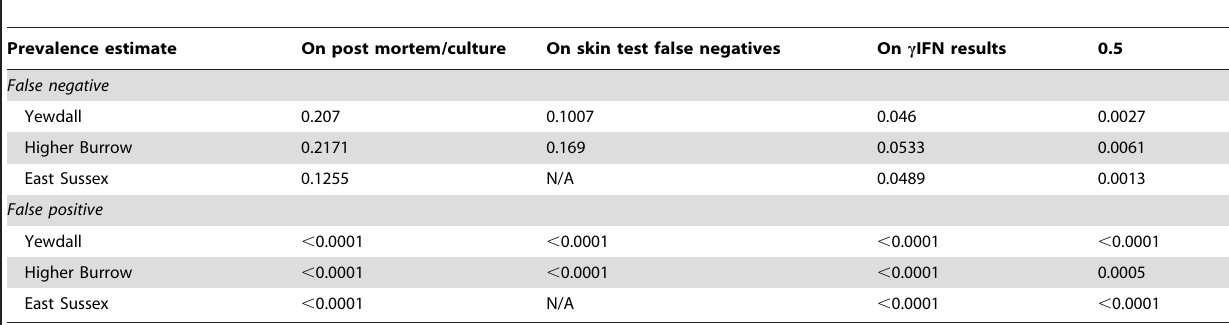
Table 2. P-values for differences in the probability densities of total numbers of false negative and false positive cattle in SICCT and c IFN expected at various prevalence estimates (given in figure